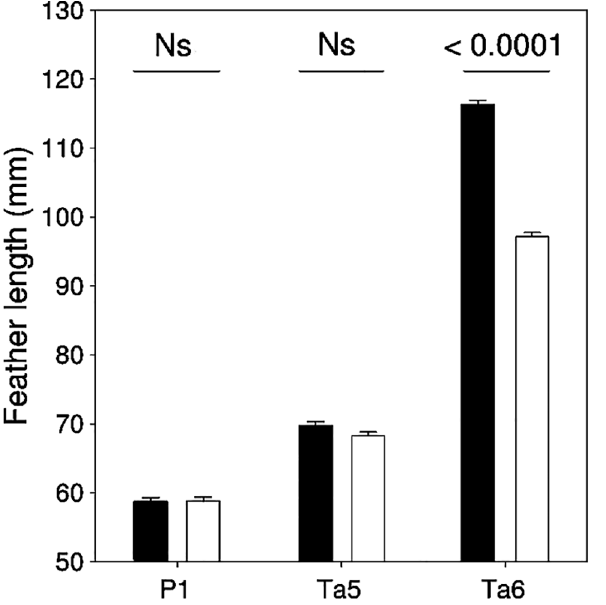
Fig 1. Variation in length of P1, Ta5 and Ta6 in male (black) and female (white) barn swallows from the Romanian population (mean + SE). Significance level for the difference between sexes for each feather types is shown above